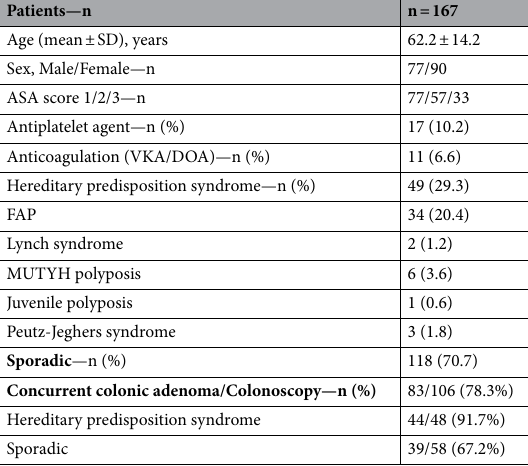
Table 1. Baseline patients characteristics. VKA: Vitamin K antagonist; DOA: Direct oral anticoagulant; n: number; SD: standard deviation; ASA: American society of anesthesiologists; FAP: Familial adenomatous polyposis; D1: First duodenum; D2 Second